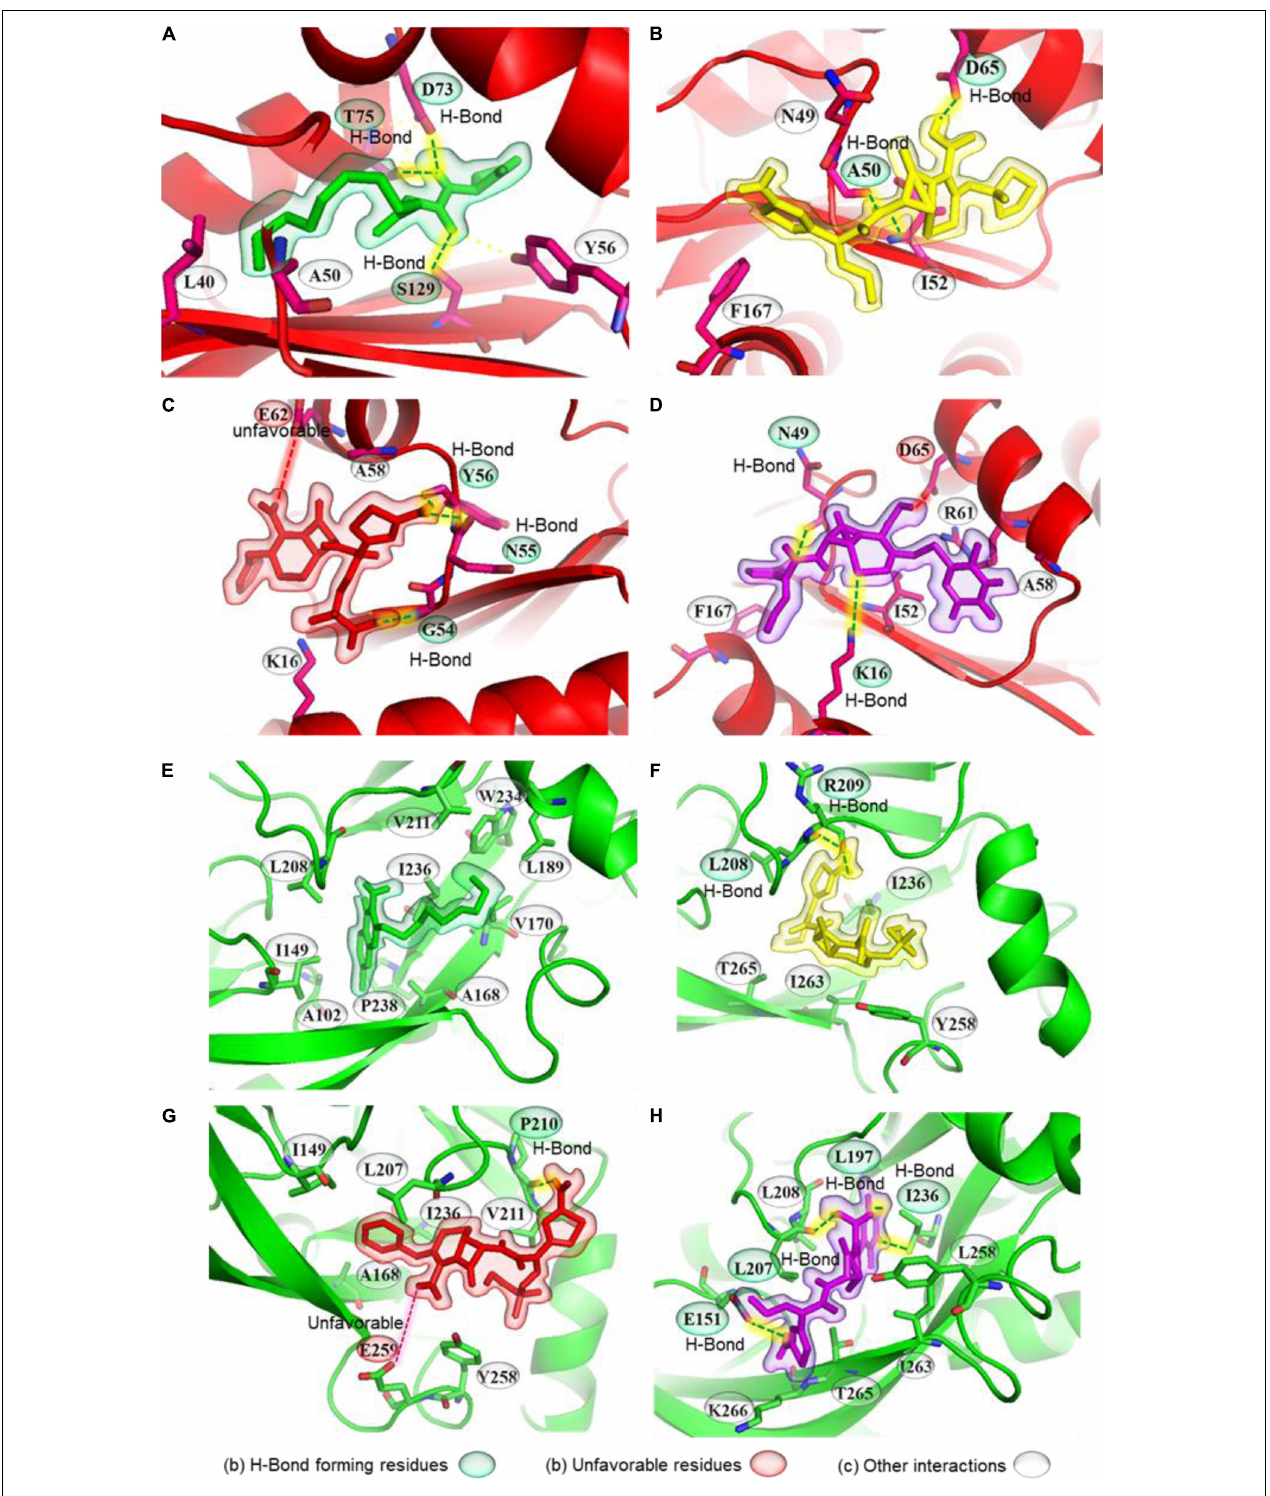
FIGURE 7 | Molecular interactions of natural ligand and cephalosporin antibiotics with Pseudomonas aeruginosa QS receptors (LasR and PqsR). Representation of ligand-receptor interactions of 3oxo-C12-HSL (A) , CP (B) , CF (C) , CT (D) with LasR QS receptor. Representation of ligand-receptor interactions of Pseudomonas quinolone signaling (PQS) molecule (E) , CP (F) , CF (G) , CT (H) with PqsR QS receptor. LasR and PqsR receptors are represented as red and green. Natural ligands of receptors, CP, CF, and CT, are presented as green, yellow, red, and purple.